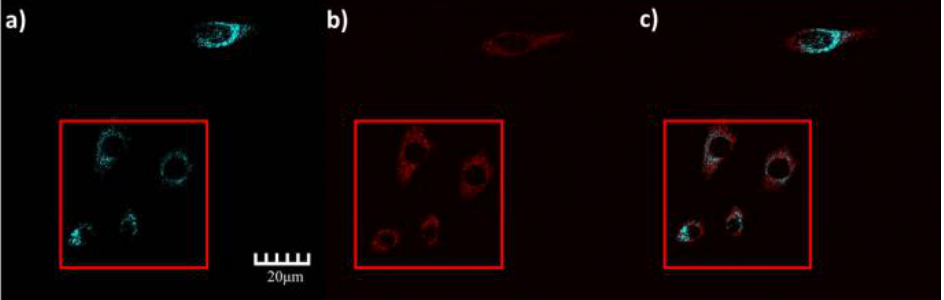
Figure 7. Confocal microscopy images of living 4t1 cells incubated by P (10 μM), Mito Tracker Red (200 nM). ( a ) cells were incubated with P for 30 min, and then Mg 2+ (10 μM) for 30 min ; ( b ) cells were incubated with P for 30 min, Mg 2+ (10 μM) for 30 min , and Mito Tracker Red for 10 min at 37 °C subsequently; ( c ) overlay field image of cells in panel ( a , b ).